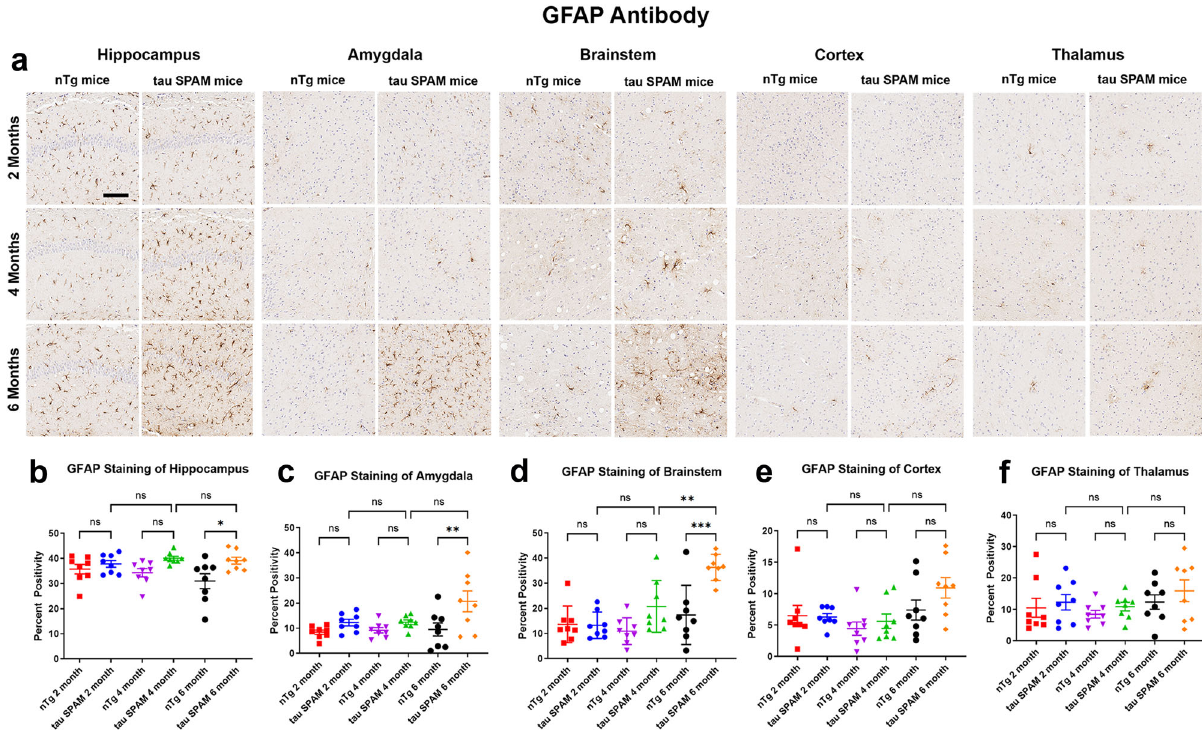
Fig. 7 Astrogliosis is delayed compared with tau-inclusion formation in tau SPAM mice. a IHC with anti-GFAP antibody for reactive astrocytes was used to stain brain samples from tau SPAM mice and nTg mice at ages 2, 4, and 6 months. GFAP immunoreactivity was signi fi cantly increased in the ( b ) hippocampus [one-way ANOVA, F (5, 42) = 3.591, p = 0.0086], ( c ) amygdala [one-way ANOVA, F (5, 42) = 4.317, p = 0.0029], and ( d ) brainstem [one- way ANOVA, F (5, 42) = 10.84, p < 0.0001] at 6 months. ( e ) Cortex and ( f ) thalamus did not show signi fi cant increase in anti-GFAP immunoreactivity ( N = 8, 4 M, 4 F for each time point). Scale bar = 100 μ m. GFAP staining was quanti fi ed with Aperio algorithms and compared using one-way ANOVA with Dunnett ’ s test. Error bars represent standard errors of the mean. *** p < 0.001, ** p < 0.01, * p < 0.05, ns not statistically signi fi